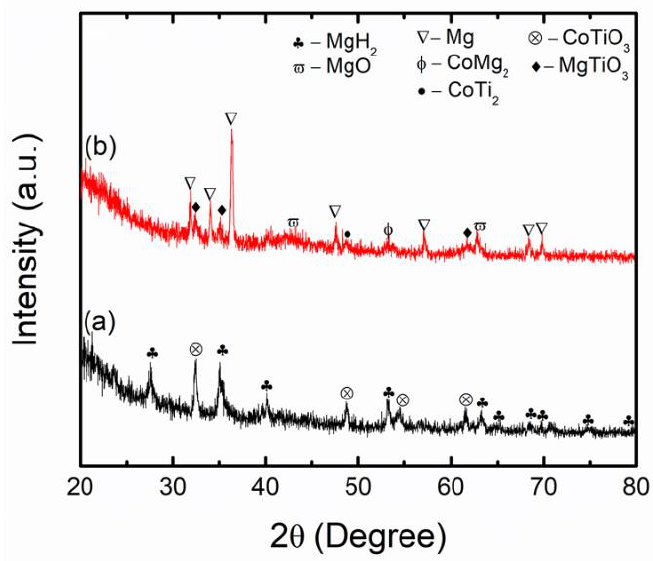
Figure 9. XRD patterns of ( a ) as-milled and ( b ) after desorption at 450 °C of MgH 2 + 50 wt.% CoTiO 3 .